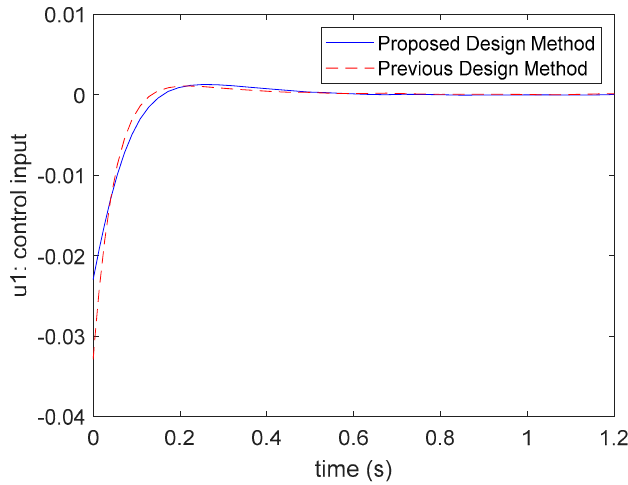
Figure 16. The comparison of control input ( )